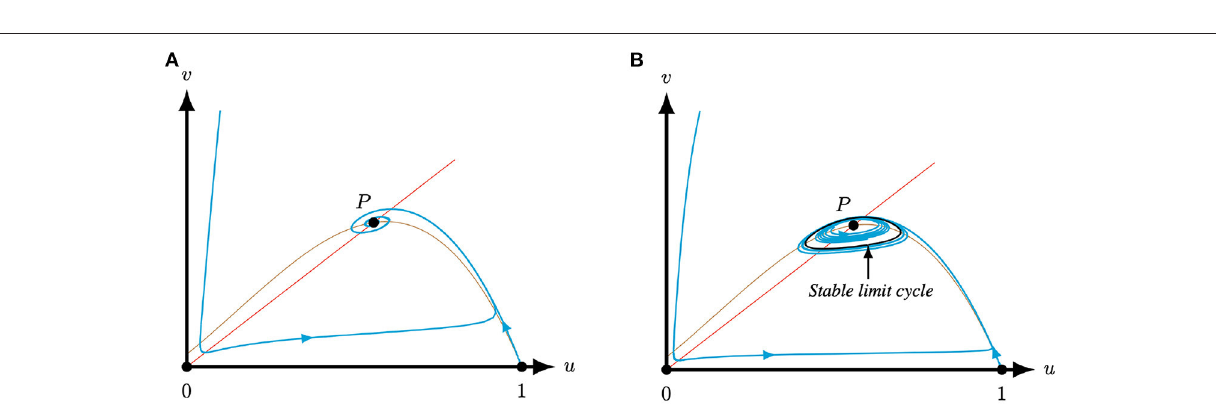
FIGURE 3 | For A 0.5, M 0.05, and Q 0.51, such that T (0.5, 0.05) > 0 and L (0.5, 0.05,0.51) > 0, i.e., case (I) of Lemma 2.1, system (4) has one positive = = − = − − equilibrium P . This equilibrium can be an attractor if S 0.1 (A) or a repeller surrounded by a limit cycle if S 0.045 (B) , see Corollary 3.2. In the latter case, the = = equilibrium is necessarily surrounded by a stable limit cycle. The brown (red) curve represents the predator (prey)